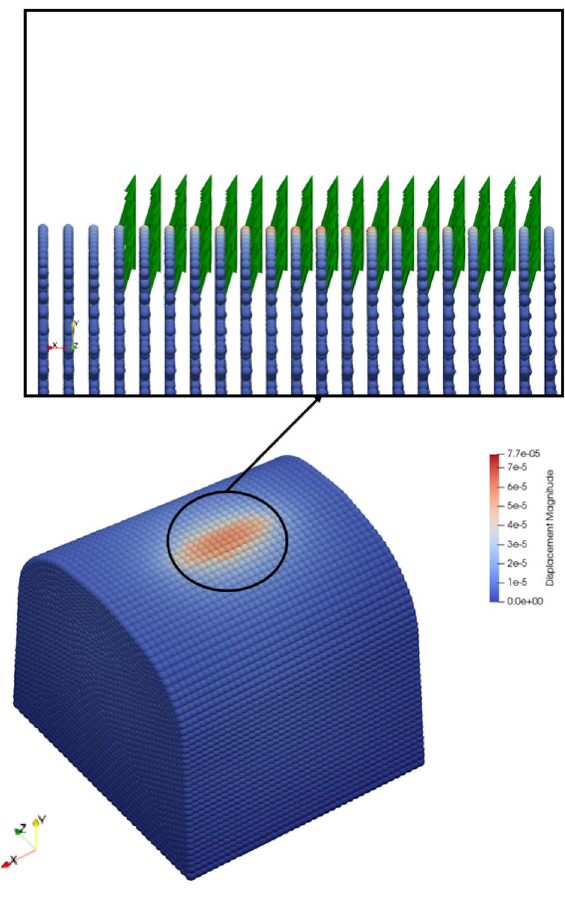
Figure 14. Force density vectors (resultant force per unit volume) at the maximum displacement over a crossing